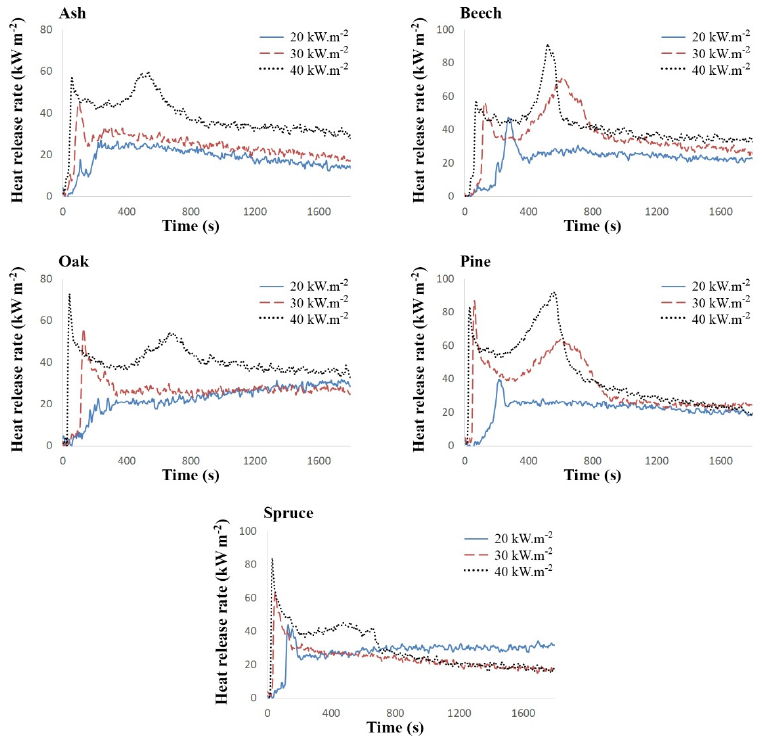
Figure 4. The change in heat release rate over time during the cone calorimeter measurements.